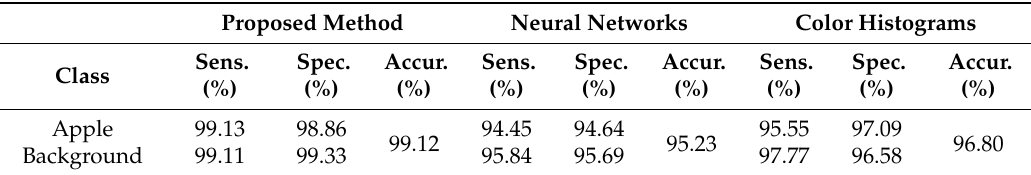
Table 10. Measures of sensitivity (Sens.), specificity (Spec.) and accuracy (Accur.) of the proposed segmentation algorithm and the two methods used for comparison: neural networks and color histogram